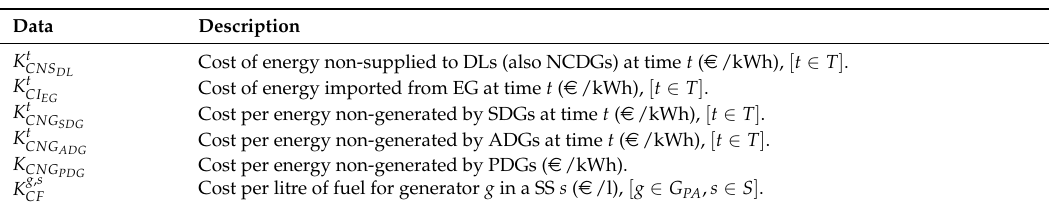
Table 3. Summary of input data (costs).